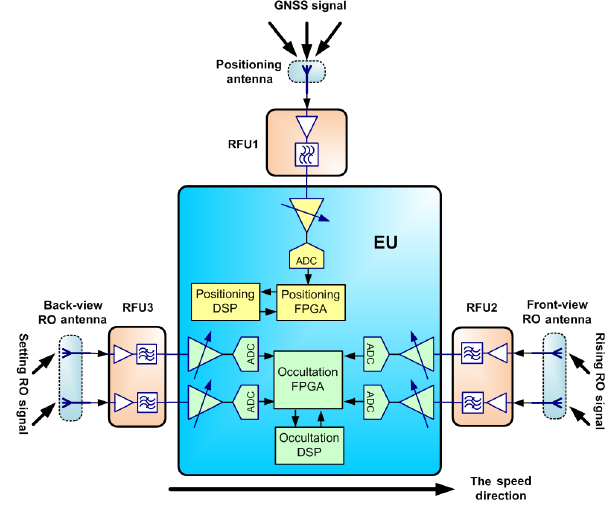
Figure 2. Design (functional block diagram) of GNOS instrument (source: Du et al.,